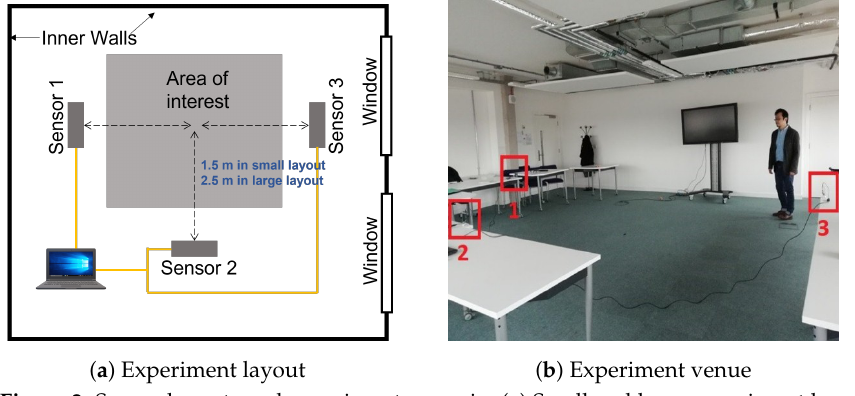
Figure 2. Sensor layouts and experiment scenario. ( a ) Small and large experiment layouts; ( b ) a real experiment scenario with the three sensors.